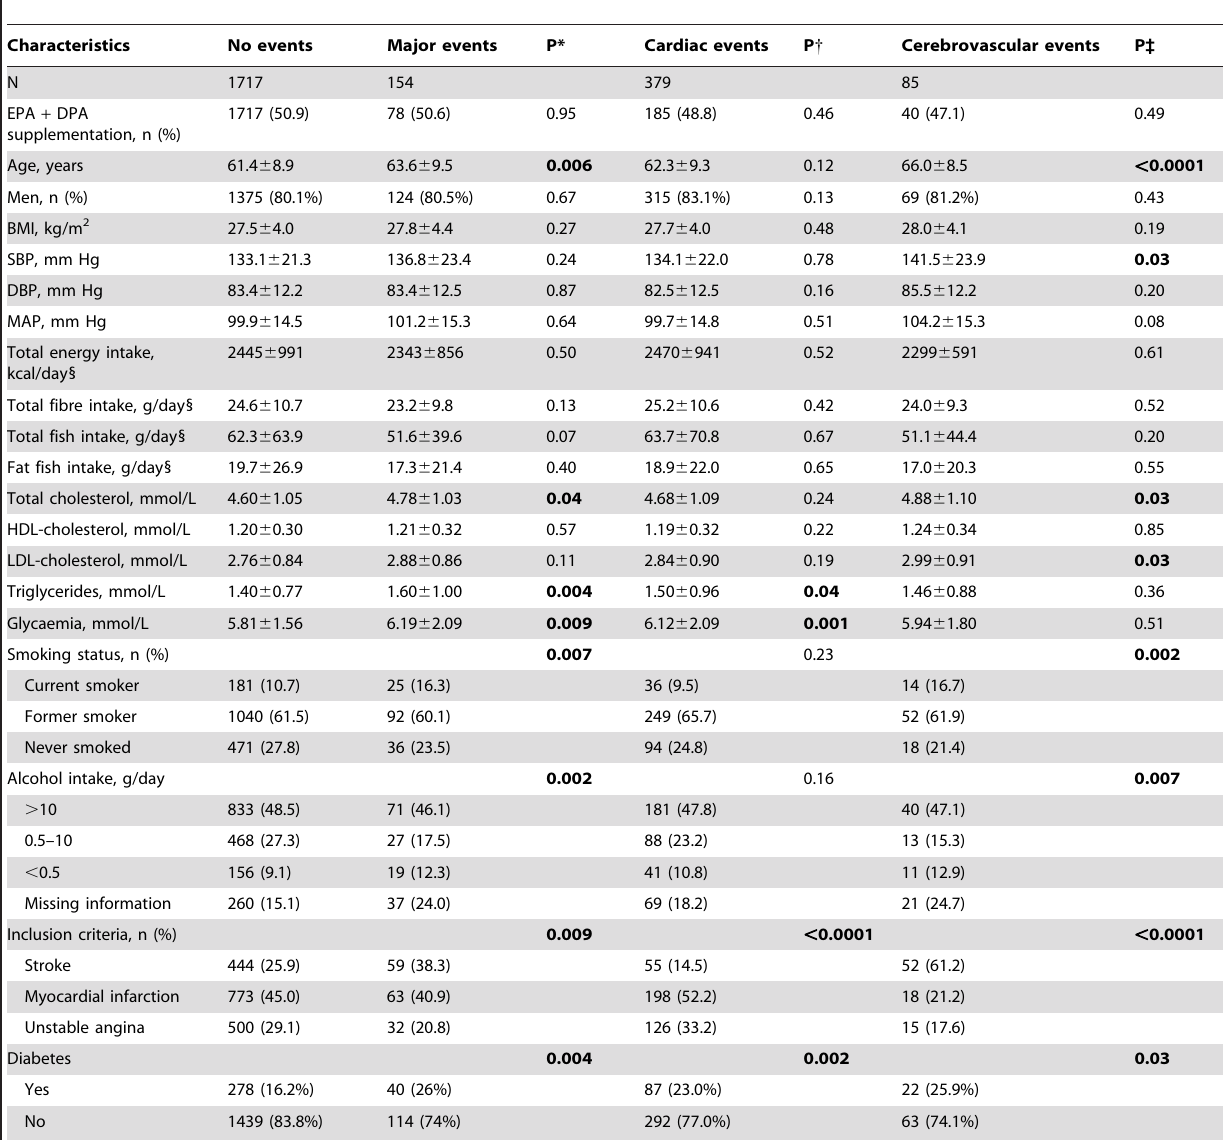
Table 1. Baseline sociodemographic, clinical and biologic characteristics of SU. FOL.OM3 participants without and with major events, cardiac and cerebrovascular events at the end of the